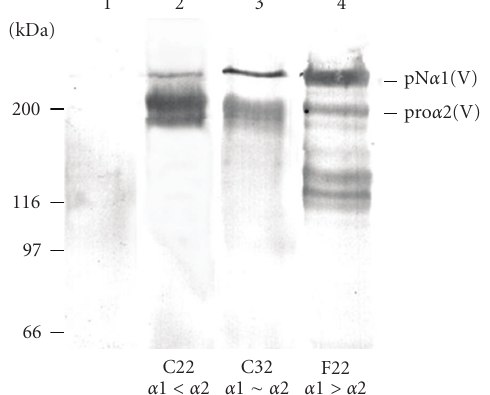
Figure 3: Selection of clones expressing α 1(V) and α 2(V) chains. Western blot analysis with antibody to collagen V of recombinant α 1(V) and α 2(V) chains synthesized and secreted in the culture medium of co-transfected HEK-293 cells. The constructs α 1(V)- pZeo-SV2 (lanes 2, 3) or α 1(V)-pcDNA-Hygro (lane 4) and the construct α 2(V)-Rc-CMV (lanes 2, 3, 4) were co-transfected into the HEK-293 cells. These cells do not naturally express these chains (lane 1). Three clones have been selected to express di ff erent ratios of α 1(V)/ α 2(V): clone C22, which expressed more of the α 2(V) chain than the α 1(V) chain, clone C32, which expressed both chains at approximately the same amount, and clone F22, which expressed more of the α 1(V) chain than the α 2(V) chain. Left, molecular mass standards expressed in